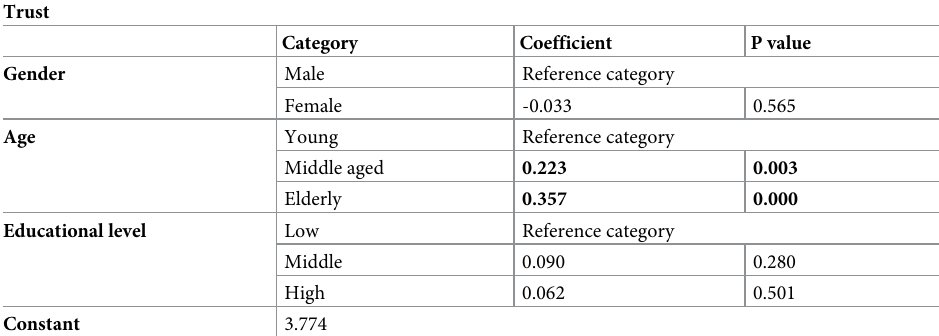
Table 4. Relationship between trust and sociodemographic characteristics, results from the regression analysis.